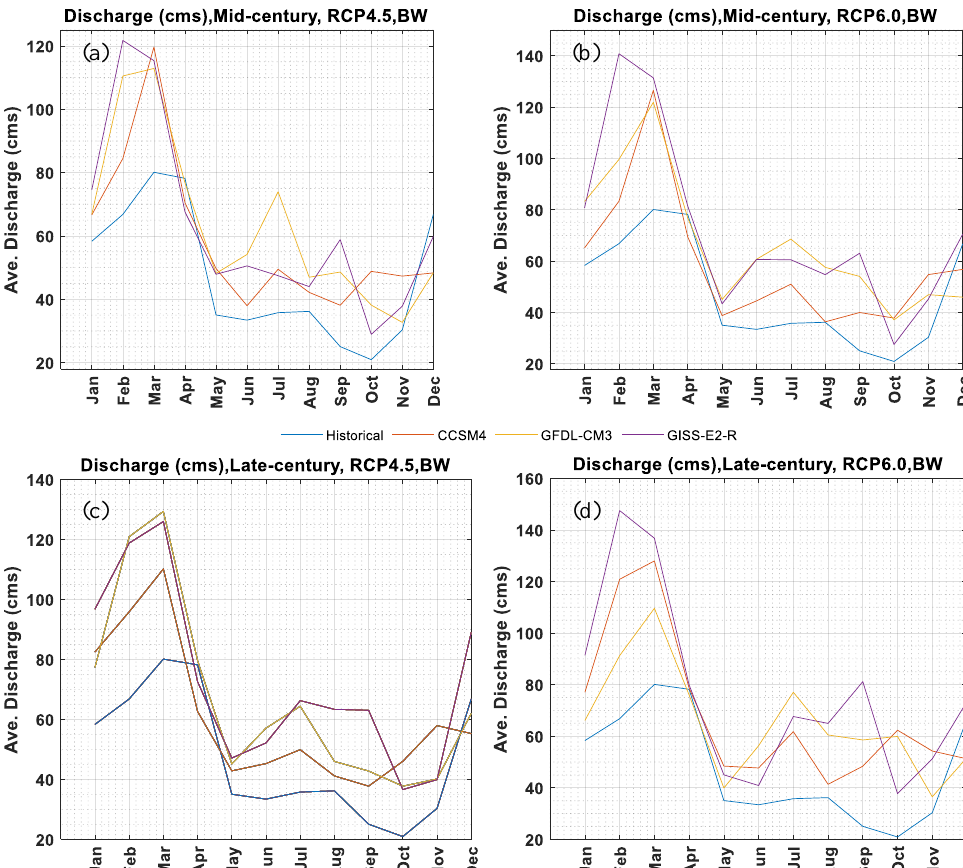
Figure 10. Monthly average discharge at Bellwood station based on the models and under RCP4.5 and RCP6.0. subgraph ( a ) shows the projected discharge amount under RCP4.5 for mid-century. Subgraph ( b ) shows the projected discharge at BW under RCP6.0 during the mid-century. subgraph ( c ) shows the projected discharge amount under RCP4.5 for late century. Subgraph ( d ) shows the projected discharge at BW under RCP6.0 during the late century.